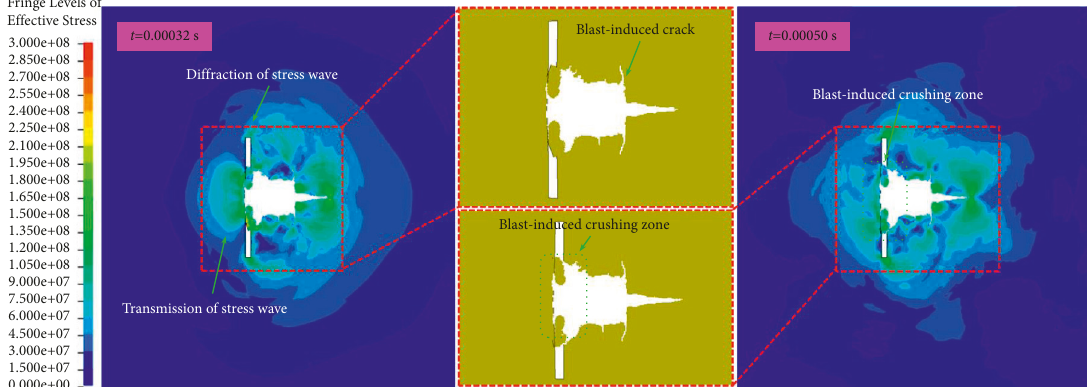
Figure 11: Pressure diagram of explosion stress wave transmission for case CN